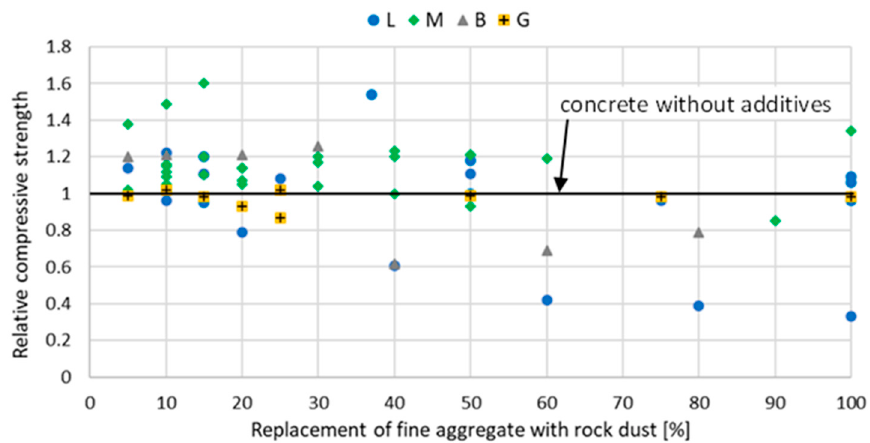
Figure 7. The effect of replacing fine aggregate with rock dust on the compressive strength of concrete after 90 days of curing: limestone dust (L) [22,33,92,98,99,111], marble dust (M) [12,33,34,93,94,100,102], basalt dust (B) [56,104,105], granite dust (G) [17,54,109].